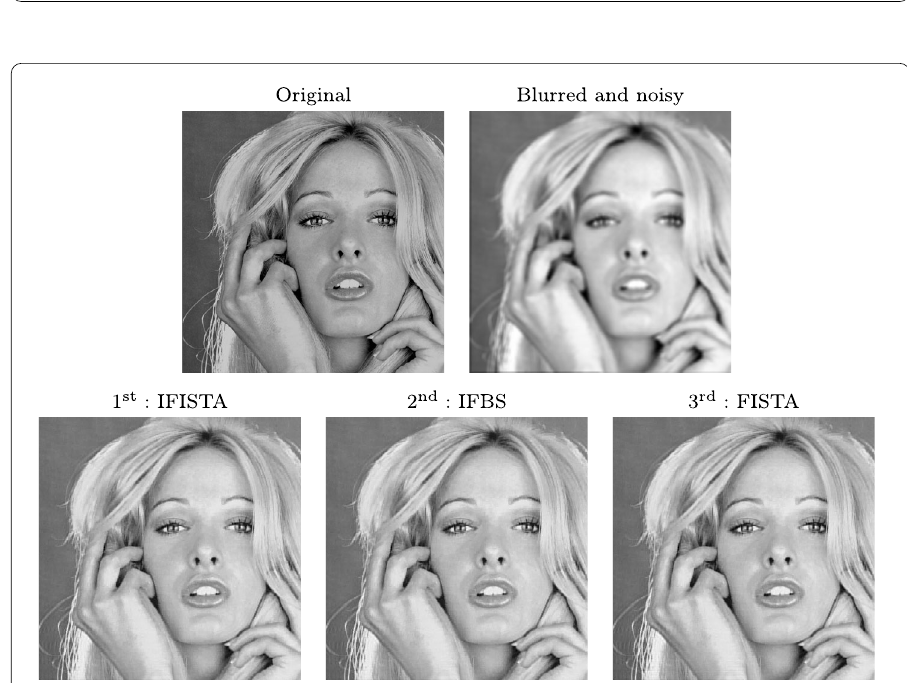
Figure 6 Top three fast processing with high performance for deblurring of Woman